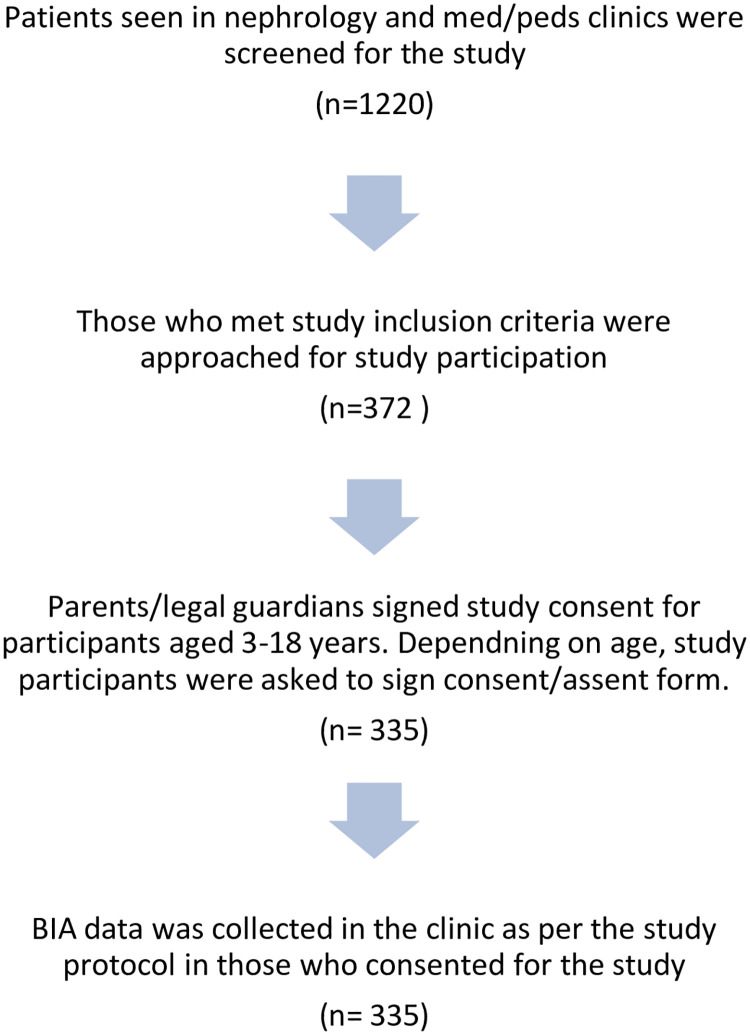
Selection of study participants for bioimpedance analysis (BIA) data collection.